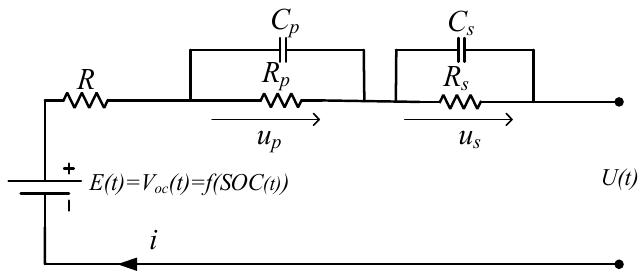
Figure 3. Second-order resistance capacitance (RC)RC battery model.